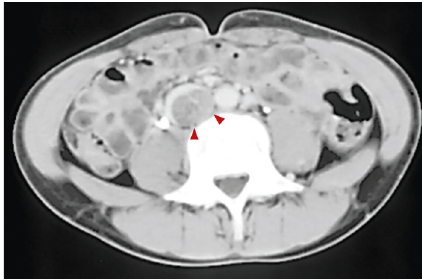
Figure 3: A contrast-enhanced CT suggesting the existence of the tumor thrombus of IVC.